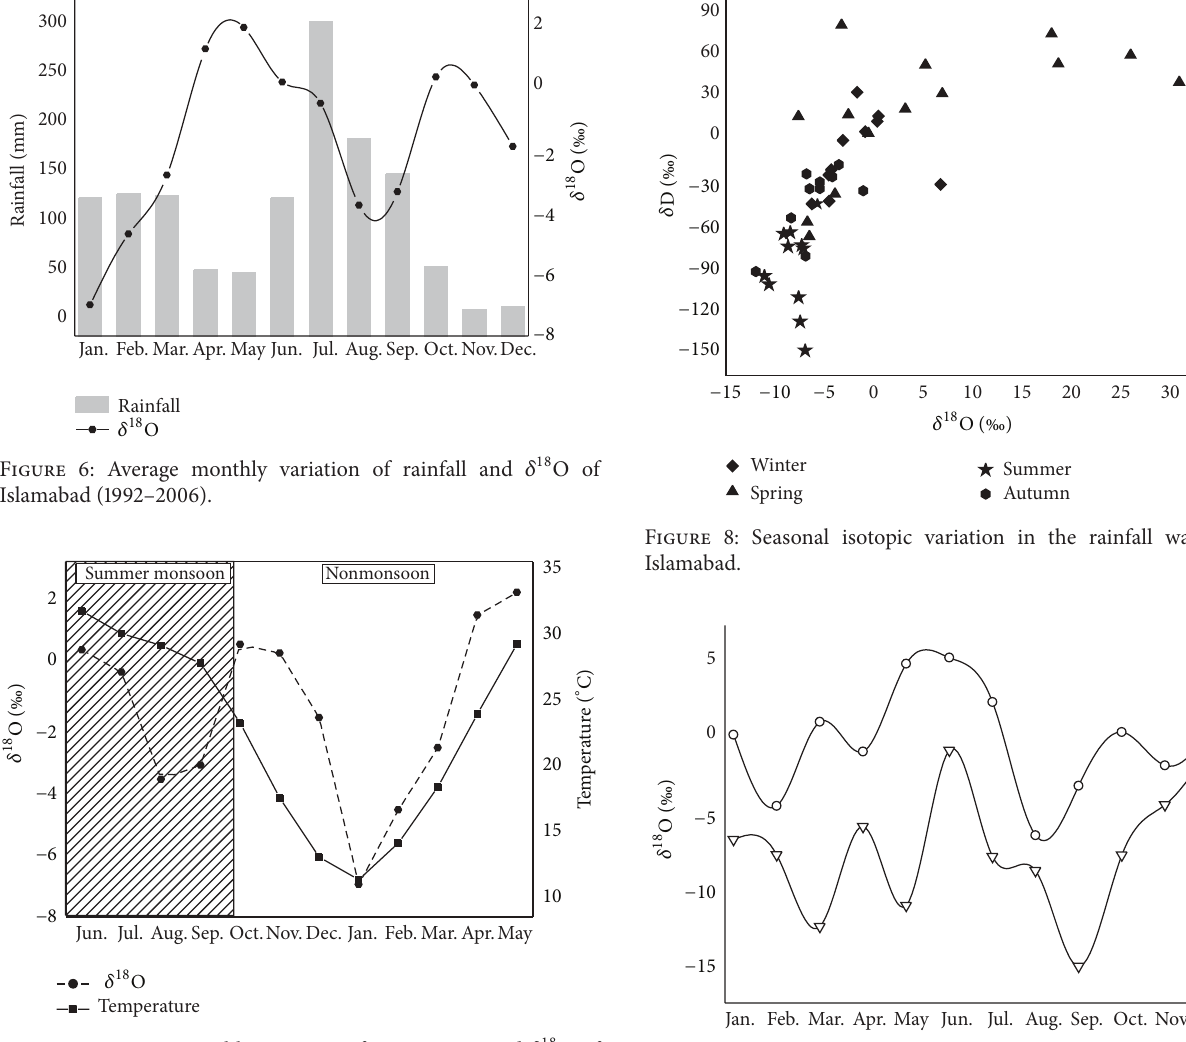
Figure 7: Average monthly variation of temperature and 𝛿 18 O of Islamabad (1992–2006).